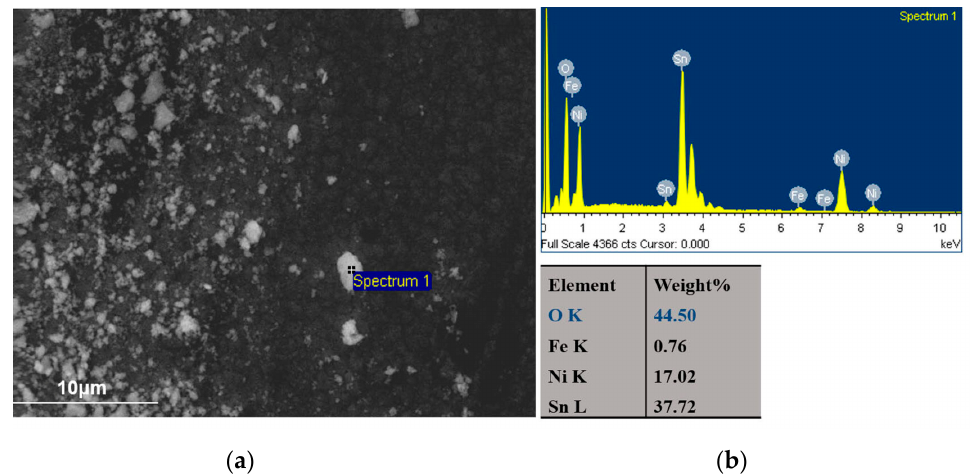
Figure 15. ( a ) SEM surface micrograph of wear debris of the pure SnNi coating-Sample I. and ( b ) EDS spectrum and analysis at grey-lighted spot 1.